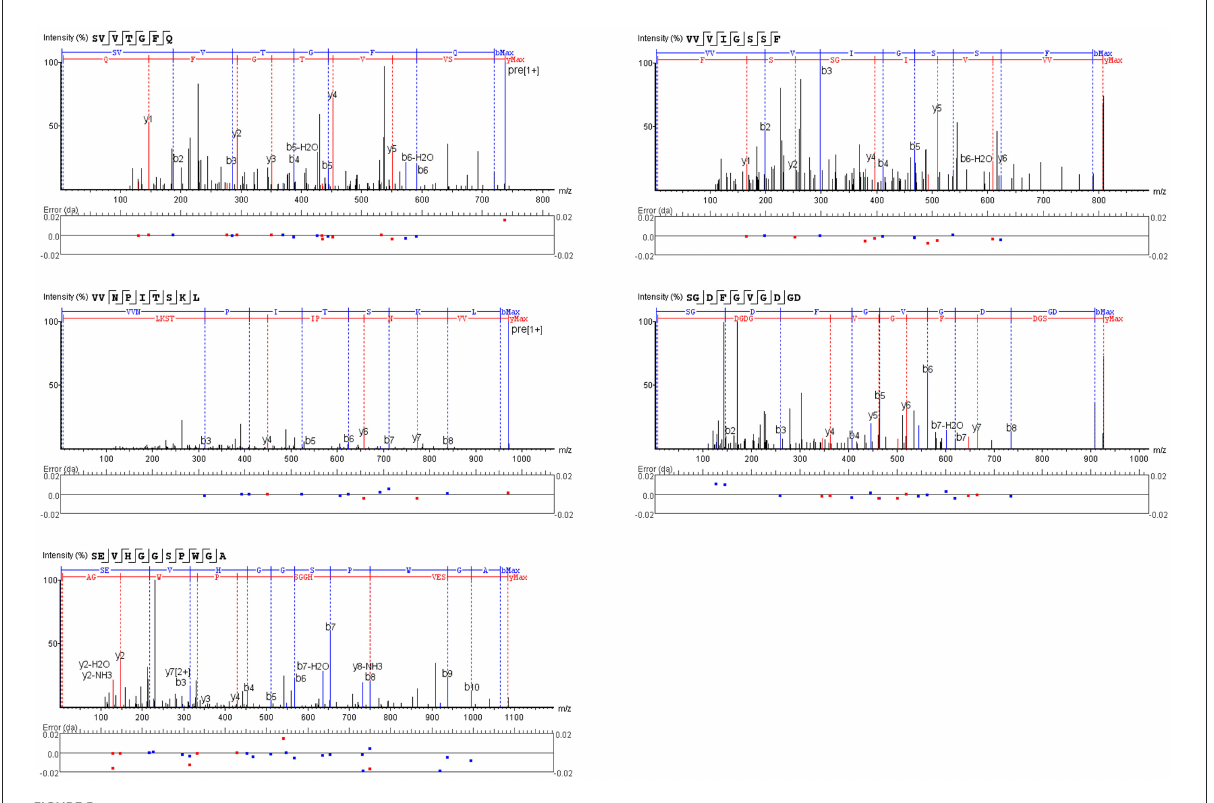
FIGURE5 A secondary mass spectrum of